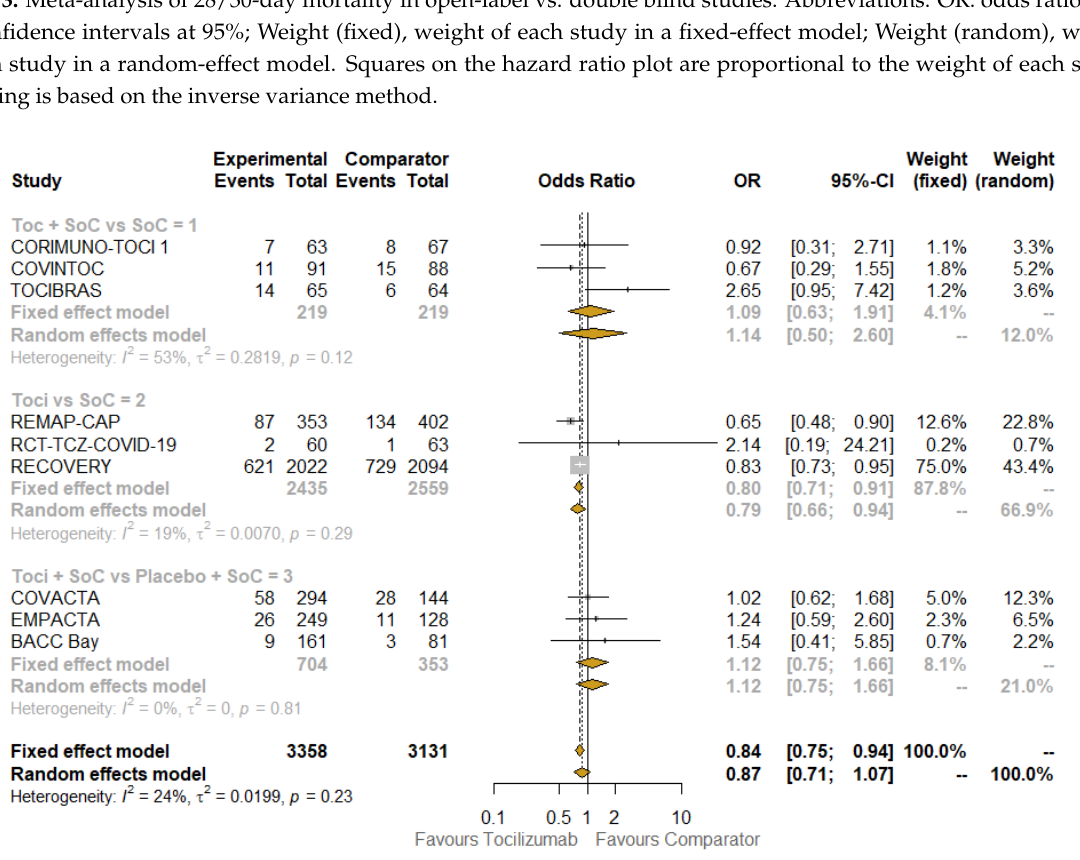
Figure 4. Pooled comparison of 28-day mortality according to treatment received. Abbreviations: Soc: standard of care; OR: odds ratio; 95% CI, confidence intervals at 95%; Weight (fixed), weight of each study in a fixed-effect model; Weight (random), weight of each study in a random-effect model. Squares on the hazard ratio plot are proportional to the weight of each study; weighting is based on the inverse variance method.